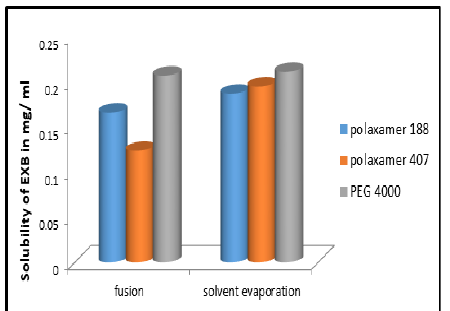
Figure 2. Effect of carrier type of EXB solid dispersion at ratio (1:1) on the solubility of EXB in distilled water at 25°C .